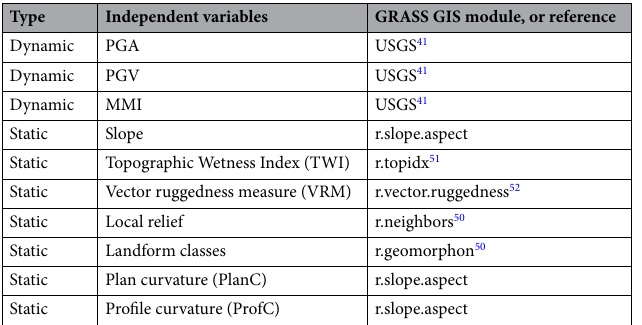
where p is the chance of phenomena (here, probability of landslide occurrence) and z is a linear combination of independent variables (here, predisposing factors). The linear combination in Eq. (2) reads as follows 45 :